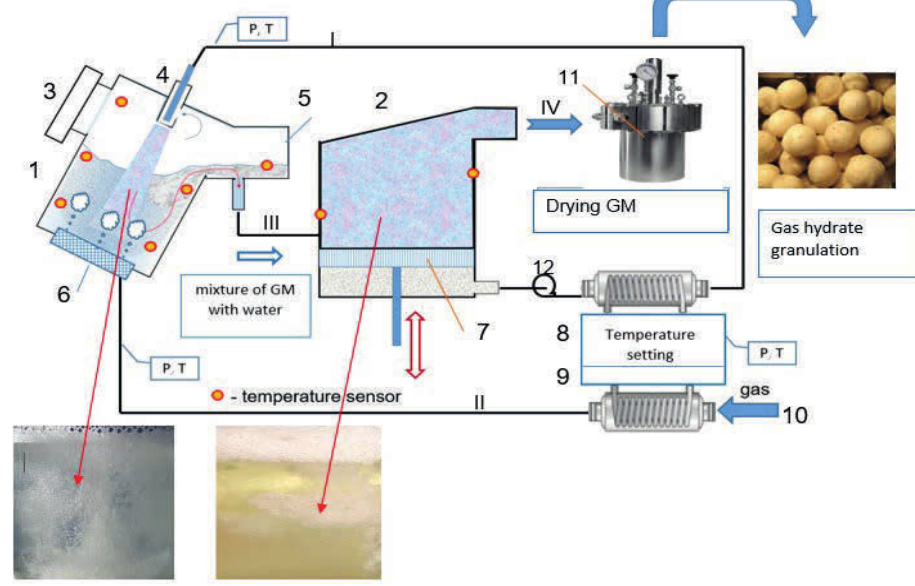
Fig. 1. Scheme of a gas hydrate plant for continuous production of gas hydrate: 1– reactor; 2 – separator 2 – temperature sensors; 3, 5 – inspection windows; 4 – jet apparatus; 5 – removal of water-gas hydrate mixture; 6 – bubbler; 7 – filter; 8, 9 – thermostats; 10 – gas; 11 – thermal chamber for hydrate drying; 12 – recirculation pump; flows: І – water under pressure; ІІ – gas; III – water-gas hydrate mixture; IV – wet hydrate for drying.